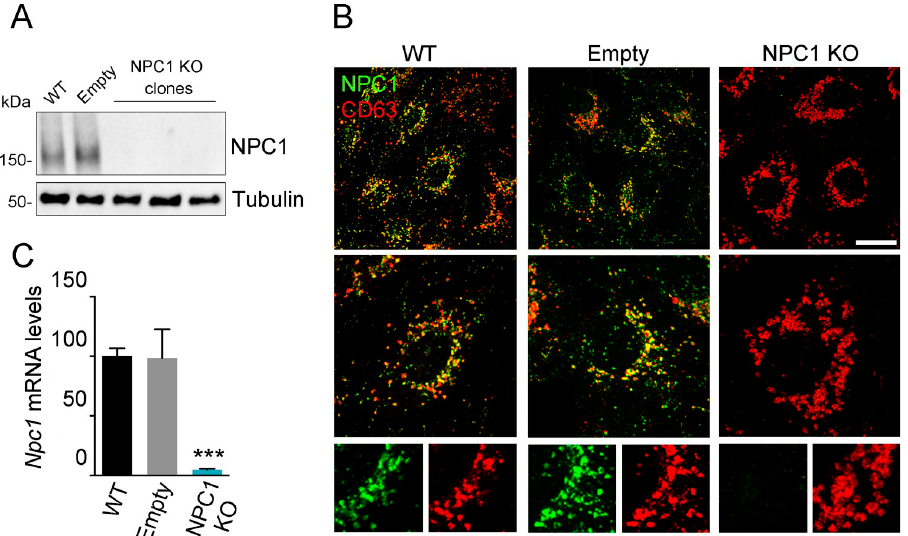
Fig 4. Validation of CRISPR KO NPC1 cells. (A) Immunoblot of NPC1 and tubulin (loading control) in samples from WT, Empty and clones of NPC1 KO cells. (B) Visualization NPC1 (green) in late endosomes (CD63, red) in WT, Empty and NPC1 Vero KO cells. Scale bar: 25 μ m. Zoom images are also shown. (C) Npc1 mRNA levels in WT, Empty and NPC1 KO cells as detected by qPCR. Graph represents mean ± sem of three independent experiments. Statistically significant differences are indicated by asterisks ( ��� p <